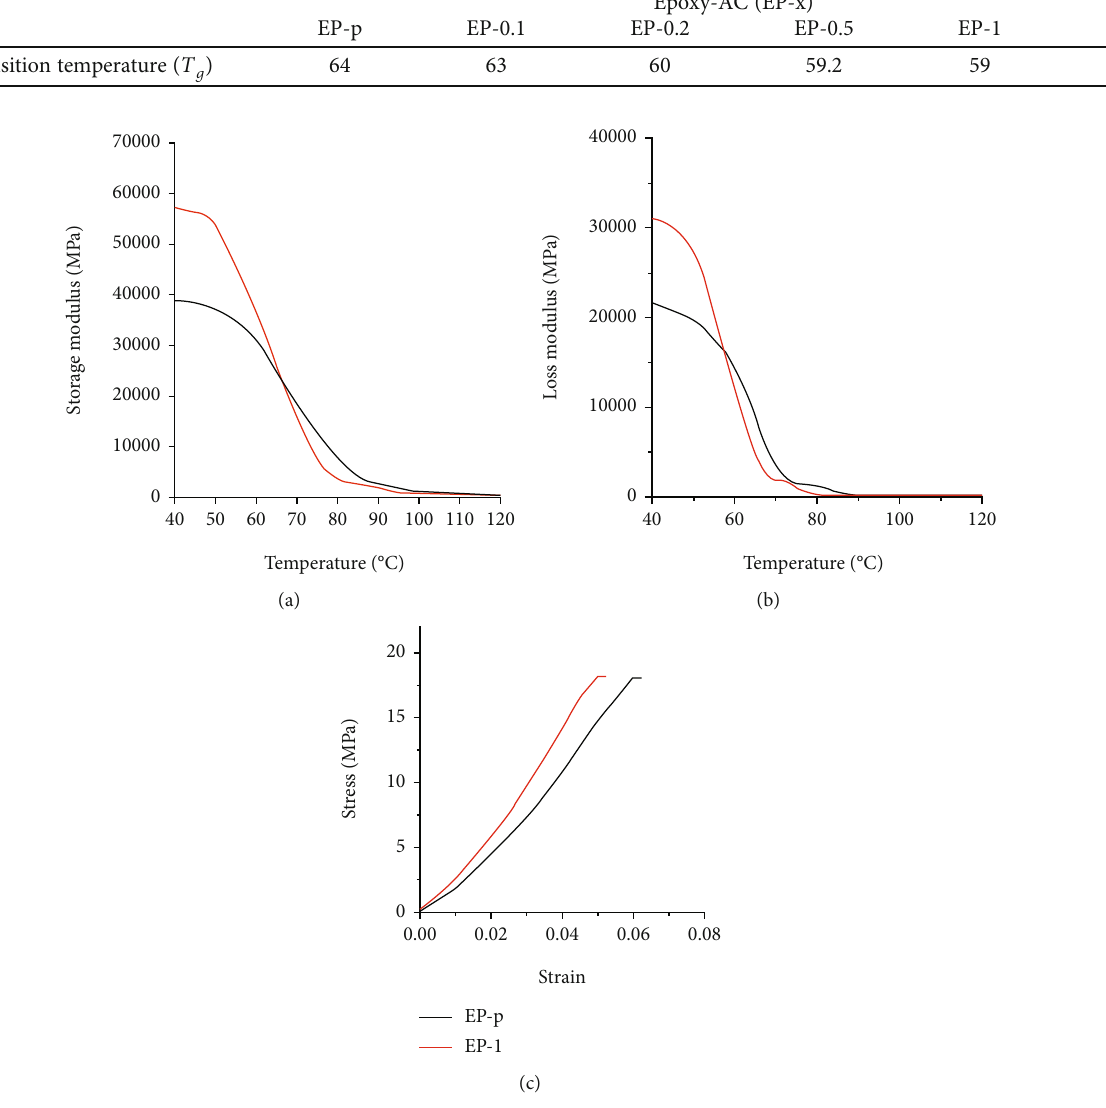
Table 1: Glass transition temperature of epoxy nanocomposites.